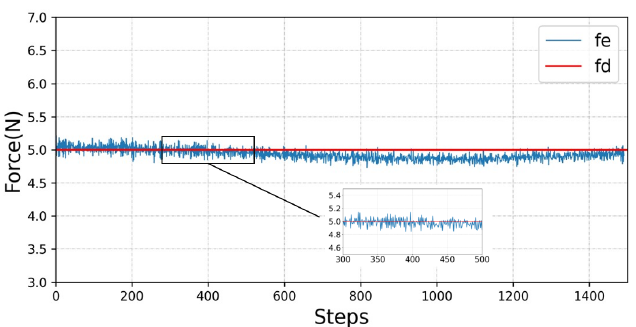
Figure 6. Constant force-tracking performance. Where f e represents the desired contact force and f d represents the acquired real-time contact force.